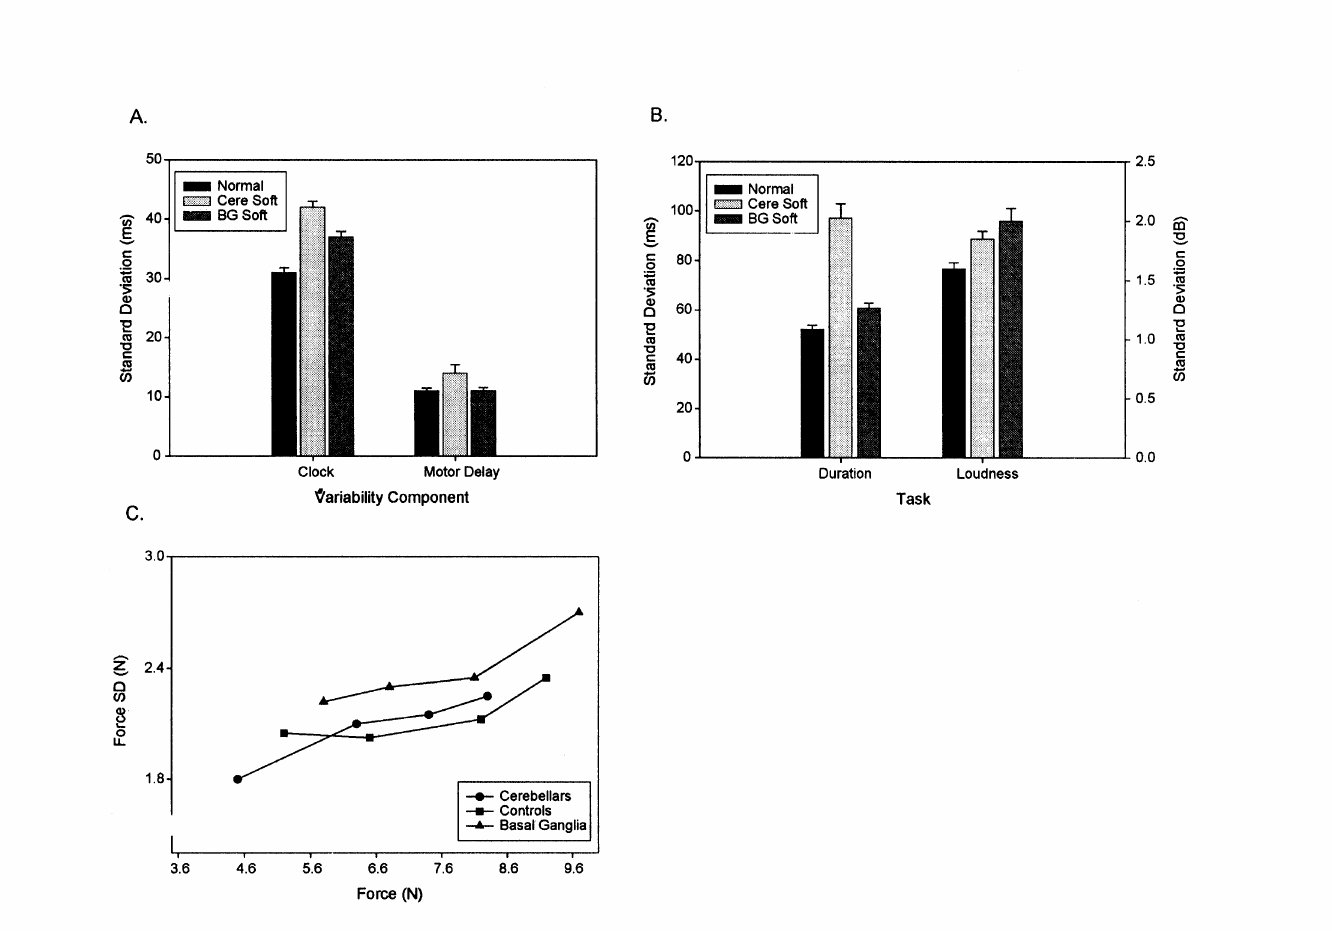
Fig. 3:Performance of normal and clumsy children on motor and perceptual tasks used to assess subcortical function. Based on an independent clinical exam, the clumsy children were divided into two groups, those with soft signs of cerebellar dysfunction and those with soft signs of basal ganglia dysfunction. (a) As in Figure 2, estimates of component sources of variability during repetitive finger tapping, and (b) difference thresholds on two perceptual discrimination tasks. (c) Variability of force pulses produced without feedback is plotted as a function of mean force produced. Adapted from Lundy-Ekman et al.